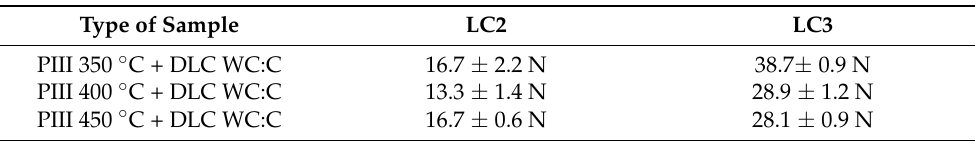
Figure 15. Scratch test of ( a ) 350 °C PIII + DLC WC:C and ( b ) the critical load LC3, ( c ) 400 °C PIII + DLC WC:C with ( d ) the LC3 and ( e ) 450 °C PIII + DLC WC:C with ( f ) the LC3. COF (blue line) and acoustic emission (AE; orange line) evolution vs. indenter displacements and optical micrographs of the scratch tracks. Table 8. Experimental data derived from the scratch tests with the corresponding values of the critical loads (LC1, LC2 and LC3) for the DLC WC:C coating sample.